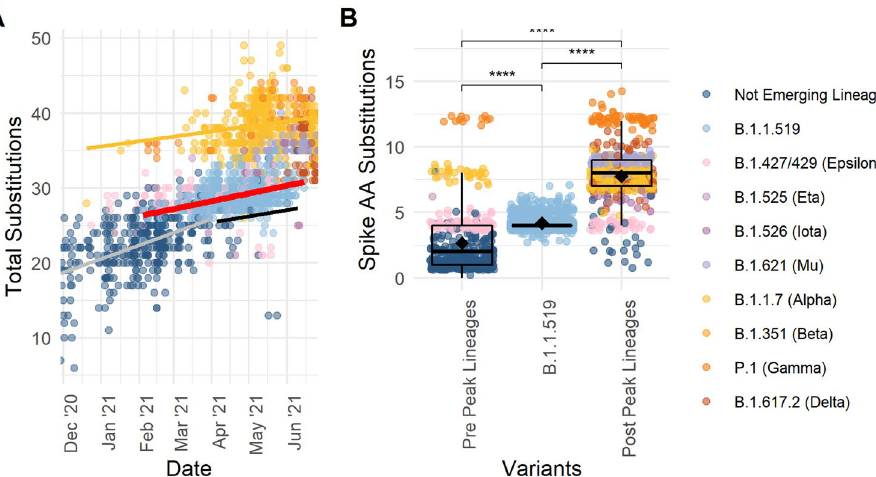
Figure 3. Amino acid substitutions in SARS-CoV-2 genomes from Alaska. Scatterplots depicting the ( A ) total AA substitutions over time. Data includes each genome from an Alaskan confirmed case, colored by variant. The lines show a generalized linear model regression of not emerging lineage cases before 2021-04-04 (gray), after 2021-04-04 (black), Alpha (yellow), and B.1.1.519 (red). ( B ) Boxplot of number of S protein AA substitutions per genome from sequences pre-peak prevalence of B.1.1.519 on 2021–04-04, B.1.1.519, and post peak prevalence genomes. Diamonds depict the mean number of AA substitutions. Points are individual genomes colored by lineage. Wilcoxon test between group significance p < 0.0001 ****, p < 0.05 *, ns >